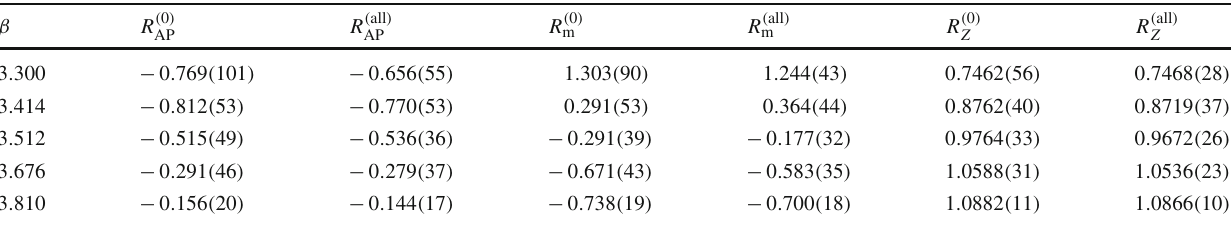
Table 2 Chirally extrapolated LCP-0 results, both for the vanishing topological charge sector, R ( 0 ) Only the former are plotted in Fig. 7